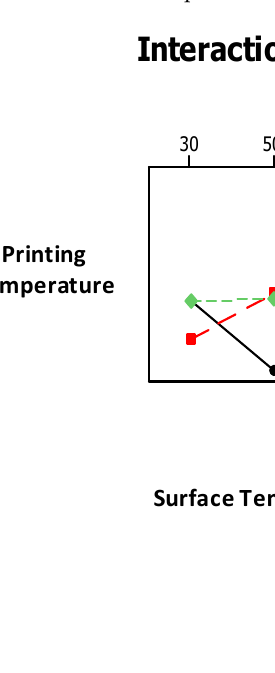
Figure 5. Interaction plot for tensile strength. FTIR analysis for ABS, HDPE, PP, and PE-g-MAH are given in Figure 6. The FTIR spectrum of High-density polyethylene (HDPE) is confirmed with C-H groups [33] at 2912.5 cm − 1 and 2846 cm − 1 . For PE-g-MAH, the polyethylene [34] is detected at 2915 cm − 1 and 2848 cm − 1 . The maleic anhydride (MAH) is detected at 1715 cm − 1 [34]. Polypropylene (PP) is confirmed with C-H peaks at 2949.6 cm − 1 , 2916.8 cm − 1 , and 2837 cm − 1 . Acrylonitrile butadiene styrene (ABS) is validated with peaks associated with acrylonitrile at 2238 cm − 1 , butadiene at 1638 cm − 1 , styrene at 1494 cm − 1